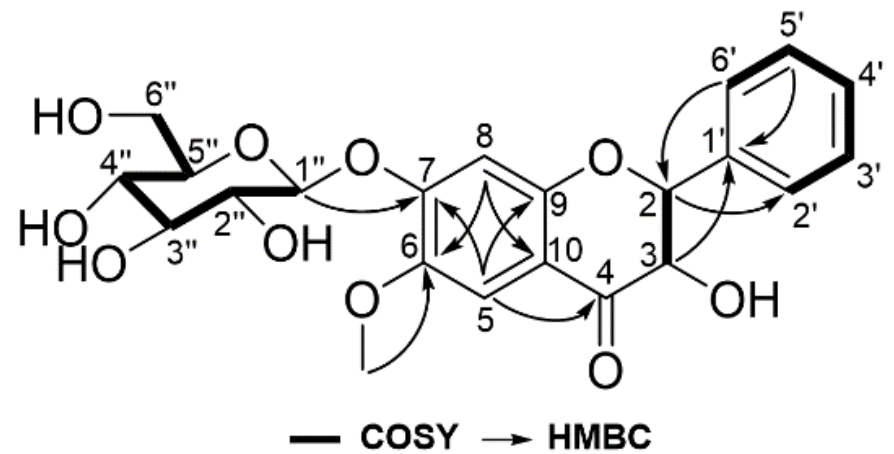
Figure 2. Key COSY and HMBC correlations of compound 2 .